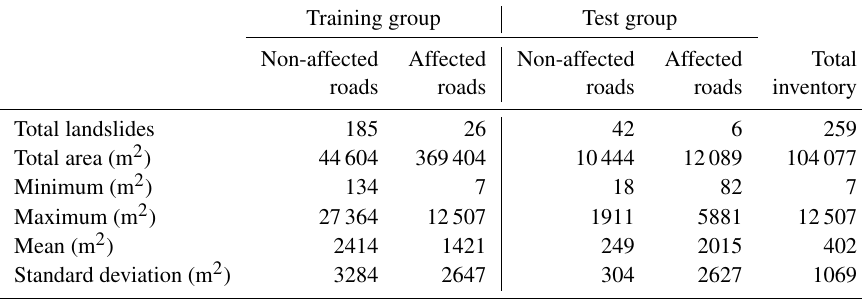
Table 3. Statistics description of the training group and test group landslide inventories.